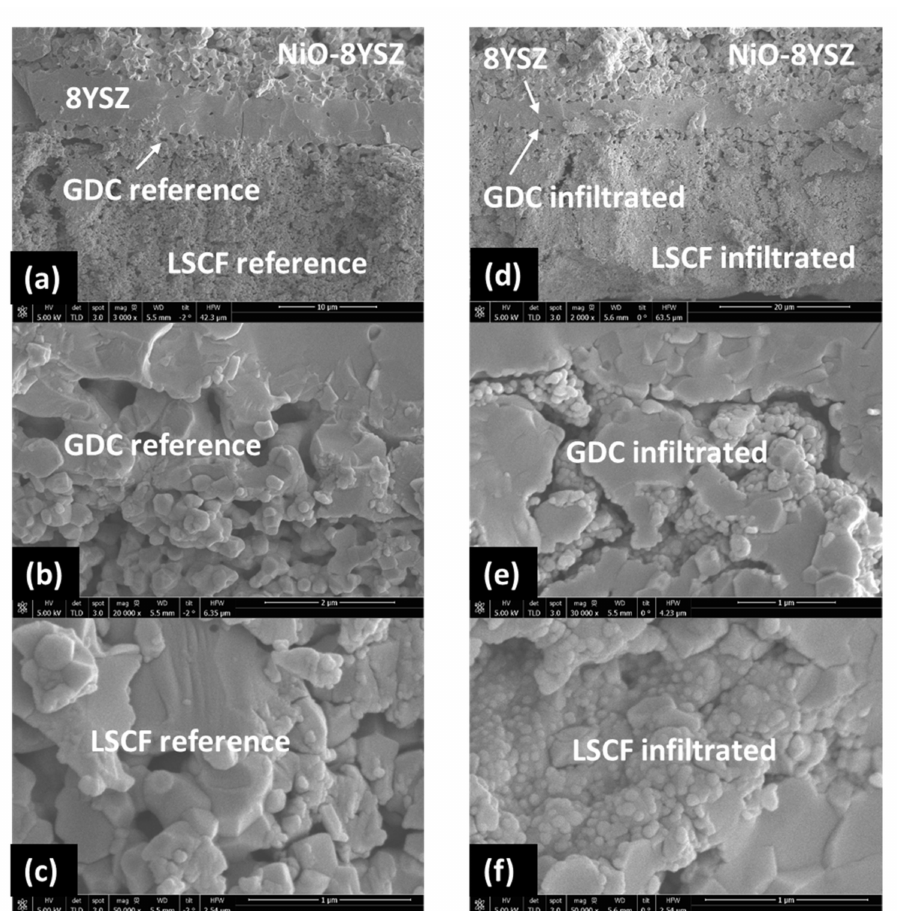
Figure 6. Post-mortem SEM cross-sectional images of the reference cell ( a – c ) and the cell infiltrated with YDC and Co x O y ( d – f ). Please note that ( a , d ) are low-resolution images of the cross sections of the anode-supported SOFCs, ( b , e ) are high-resolution images of the GDC interlayer interface areas and ( c , f ) are high-resolution images of the LSCF bulk areas. (Note also that the bar sizes on the images signify the following—for image ( a ), 10 µ m; for image ( b ), 2 µ m; for image ( c ), 1 µ m; for image ( d ), 20 µ m; and for images ( e , f ), 1 µ